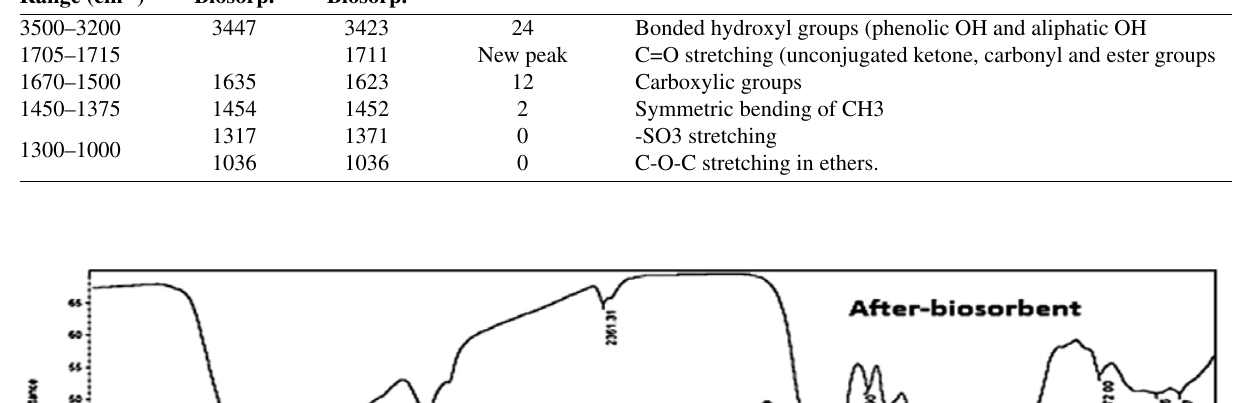
Table 7. The FTIR spectral characteristics of sweetgum bark before and after biosorption of 2,4-DCP Wavelength Before